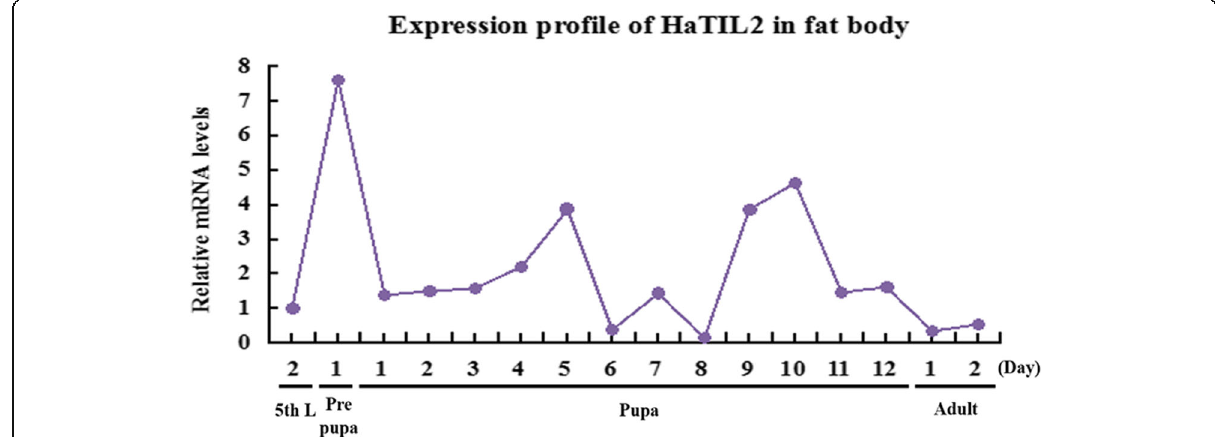
Fig. 3 Expression profiles of HaTIL2 in Helicoverpa armigera fat body tissue are shown. The expression profile of HaTIL2 in the fat body during H. armigera development was analyzed by RT-qPCR. The ribosomal protein L28 gene was used as the internal control for